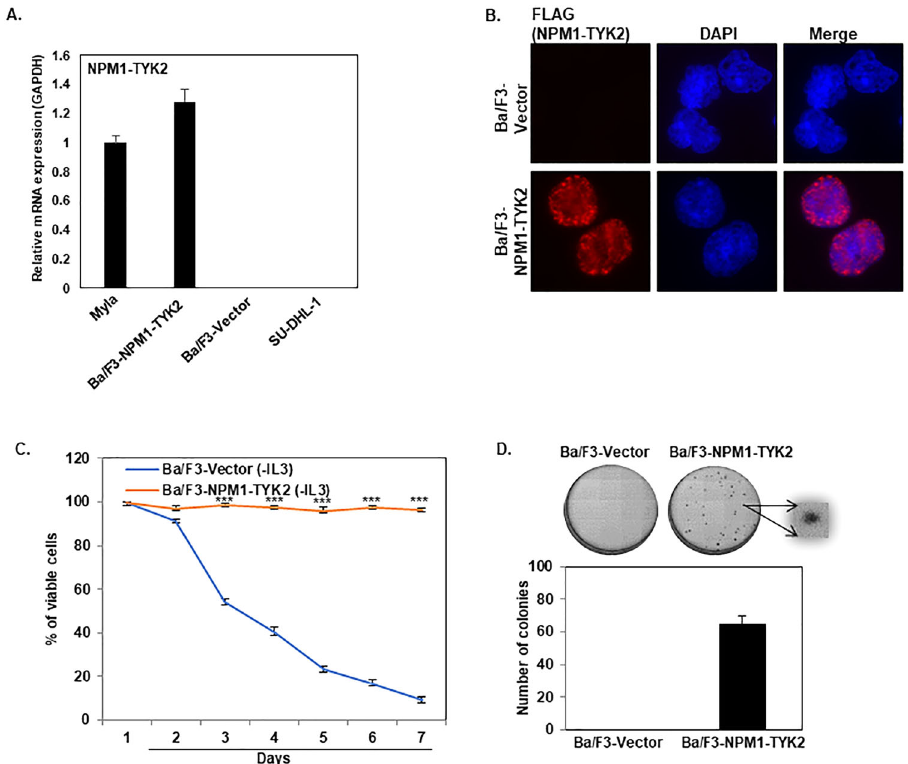
Fig. 1 In vitro transformation potential of the NPM1 – TYK2 fusion gene. A Detection of overexpressed NPM1 – TYK2 mRNA transcript levels in transformed Ba/F3 cells by qRT-PCR. Myla and SU-DHL-1 cell lines were used as positive and negative controls, respectively. Columns represent the mean of three independent experiments; bars represent the SEM. B Subcellular localization of NPM1 – TYK2. Ba/F3-Vector and transformed Ba/F3 (NPM1 – TYK2) cells were cytospun onto glass slides, fi xed, permeabilized, and stained for FLAG antibody and DAPI. Images were acquired with a fl uorescent microscope using a 60× oil immersion lens. C Transformation of Ba/F3 cells to IL-3 independent growth. Ba/ F3-Vector and transformed Ba/F3 (NPM1 – TYK2) cells were grown in RPMI medium in the absence of IL-3. Cell viability from each condition was determined daily by trypan blue exclusion assay. Points represent the mean of three independent experiments; bars represent SEM. ∗∗∗ P < 0.0005 was considered as statistically extremely signi fi cant. D The clonogenic potential of transformed Ba/F3 (NPM1 – TYK2) cells. Ba/F3-Vector and transformed Ba/F3 NPM1 – TYK2 cells were mixed with MethoCult medium and plated. After 7 days of incubation, the number of colonies was counted. Columns represent the mean of three independent experiments; bars represent the